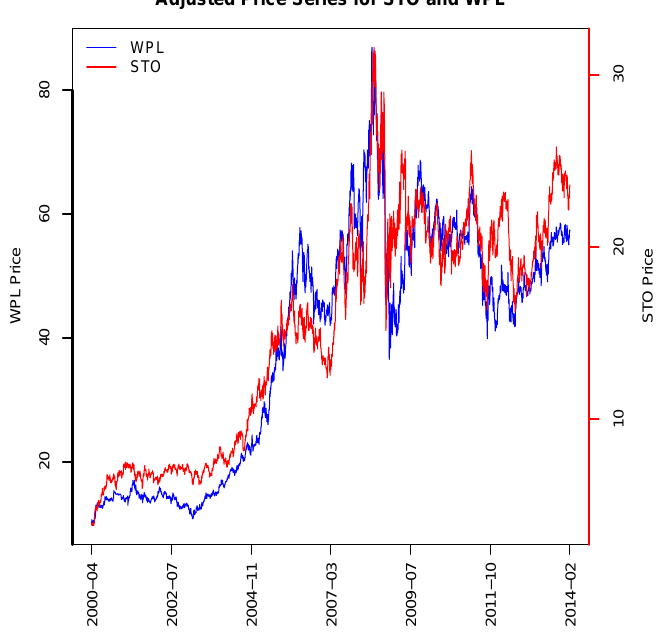
Figure 6. Time series plot of two stocks in the Oil & Gas industry identified in the scatter plot of components 151 and 152: Santos (STO) and Woodside Petroleum